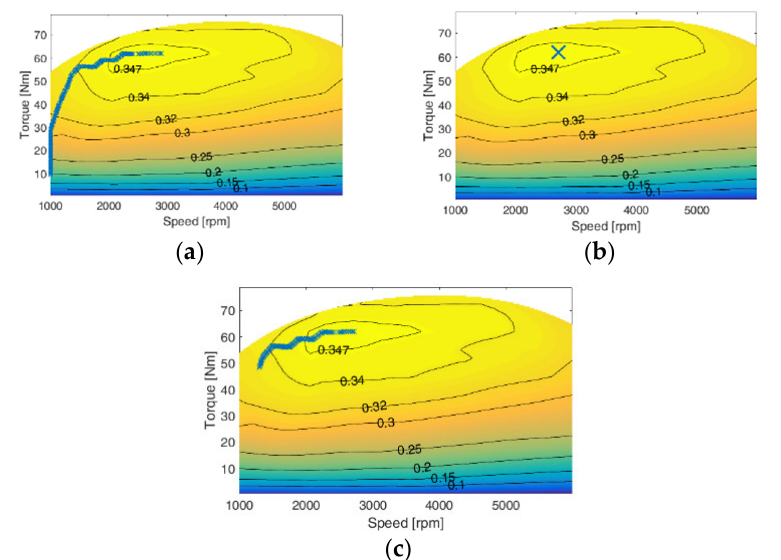
Figure 30. Power-follower ( a ), thermostat ( b ), and proposed EMS ( c ) engine working points (fast- urban mission).